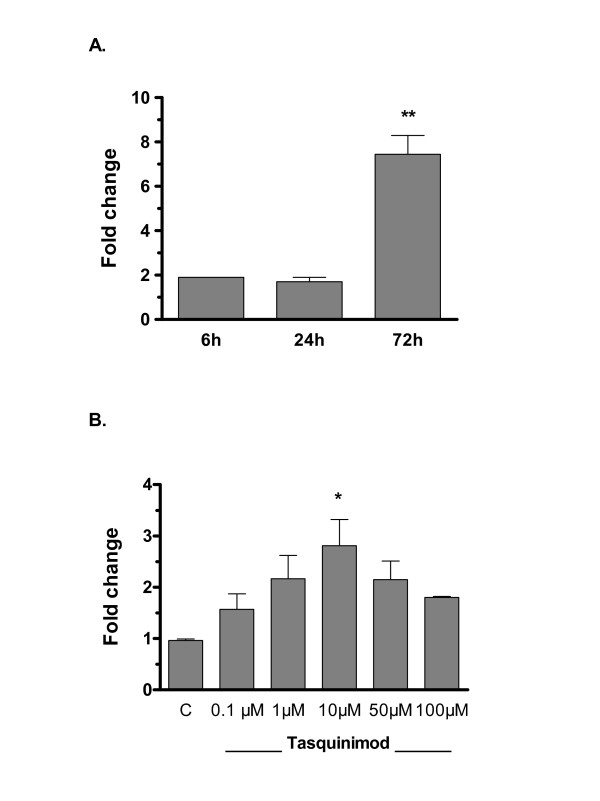
TSP1 mRNA induction by tasquinimod in in vitro tumor cell cultures. Tasquinimod-induced mRNA expression in LNCaP cells measured by real time semi-quantitative RT-PCR. (A) Time study after in vitro exposure with 10 μM tasquinimod, and (B) dose response with tasquinimod treatment between 0.1-100 μM for 72 h (p = 0.0128, ANOVA). Data expressed represents the mean ± SD of at least two independent experiments. (*) p ≤ 0.05 and (**) p ≤ 0.01 compared with untreated control (Bonferroni's multiple comparison test).